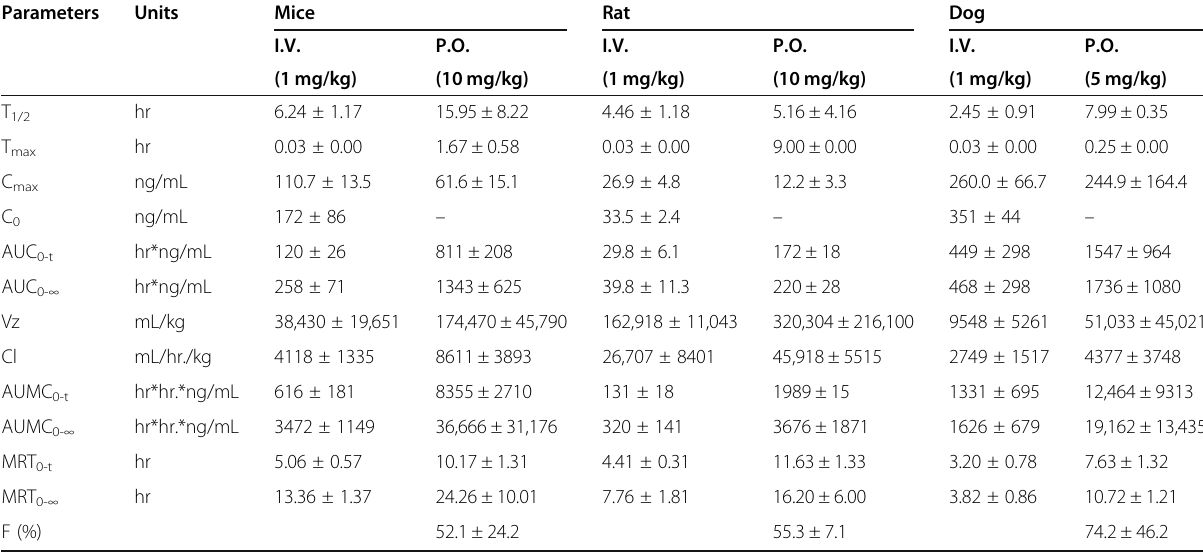
Table 1 In vivo pharmacokinetic parameters of emetine in mice, rats and beagle dogs ( n = 3) Parameters